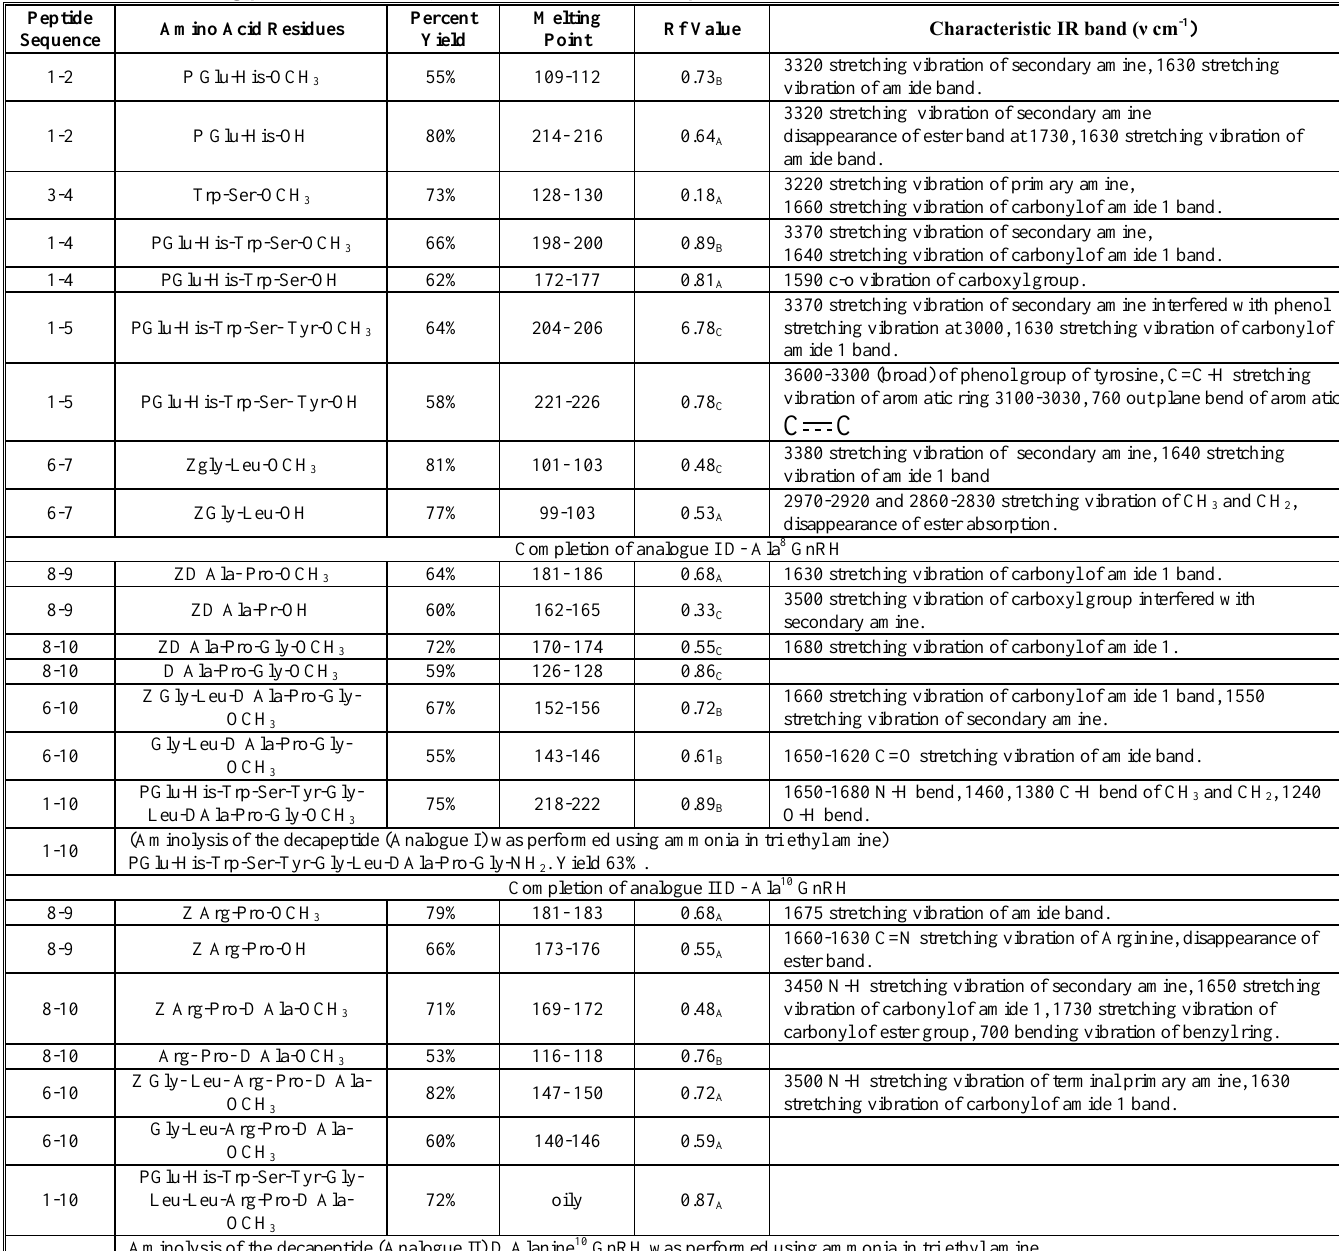
Table 5: Some physico-chemical properties of the synthesized intermediate peptides (Percent yield, Melting points, Rf values, and Characteristic IR